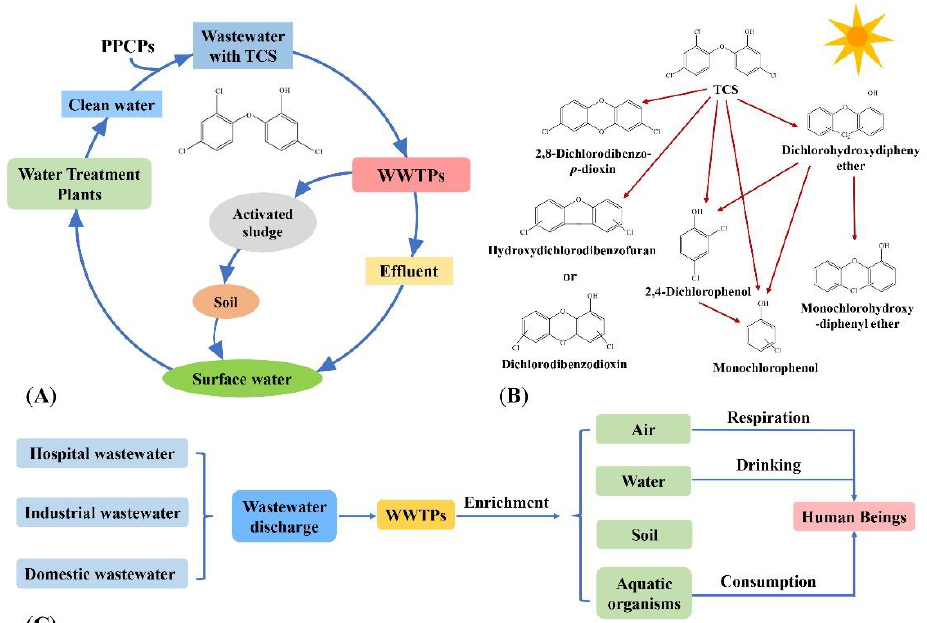
Figure 1. Occurrence of TCS in the water environment. ( A ) The circulation of TCS in the water environment. ( B ) Photodegradation products of TCS [32,33]. Reprinted with permission from Ref. [32]. 2022, Dar et al.; and Ref. [33]. 2008, Sanchez-Prado et al. ( C ) The fate of TCS in the water environment. After the wastewater-containing TCS is treated by WWTPs, part of TCS is adsorbed by the sludge, and the other part is degraded by microorganisms. The concentrations of TCS in the influent, effluent and sludge of some WWTPs are shown in Table 1. Table 1. The concentrations of TCS in